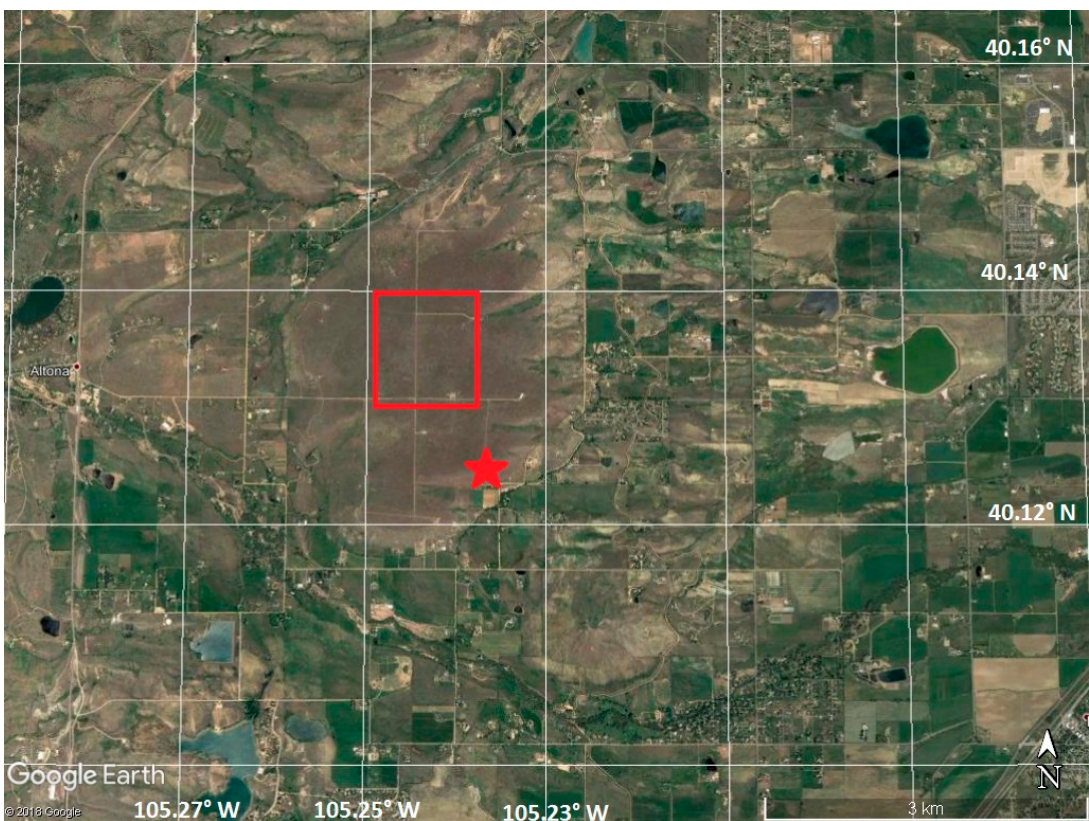
Figure 4. Google Earth true-colour satellite image of Table Mountain. The inserted red star indicates the location of Table Mountain (TBL) station and the red rectangle gives the nominal position of the pixel used for validation. The white lines are lines of constant latitude or longitude.